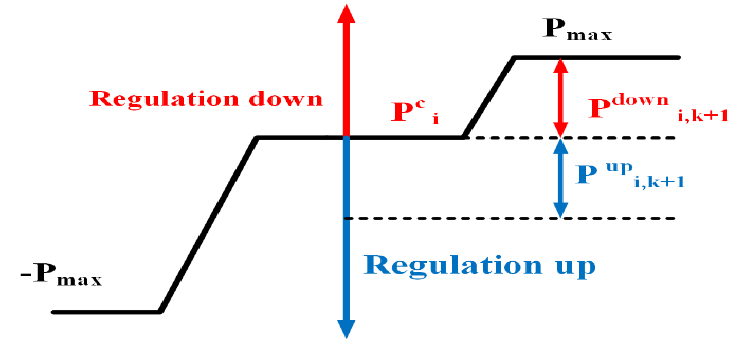
Figure 6. Proposed V2G power of electric vehicles to regulate the battery SOC.